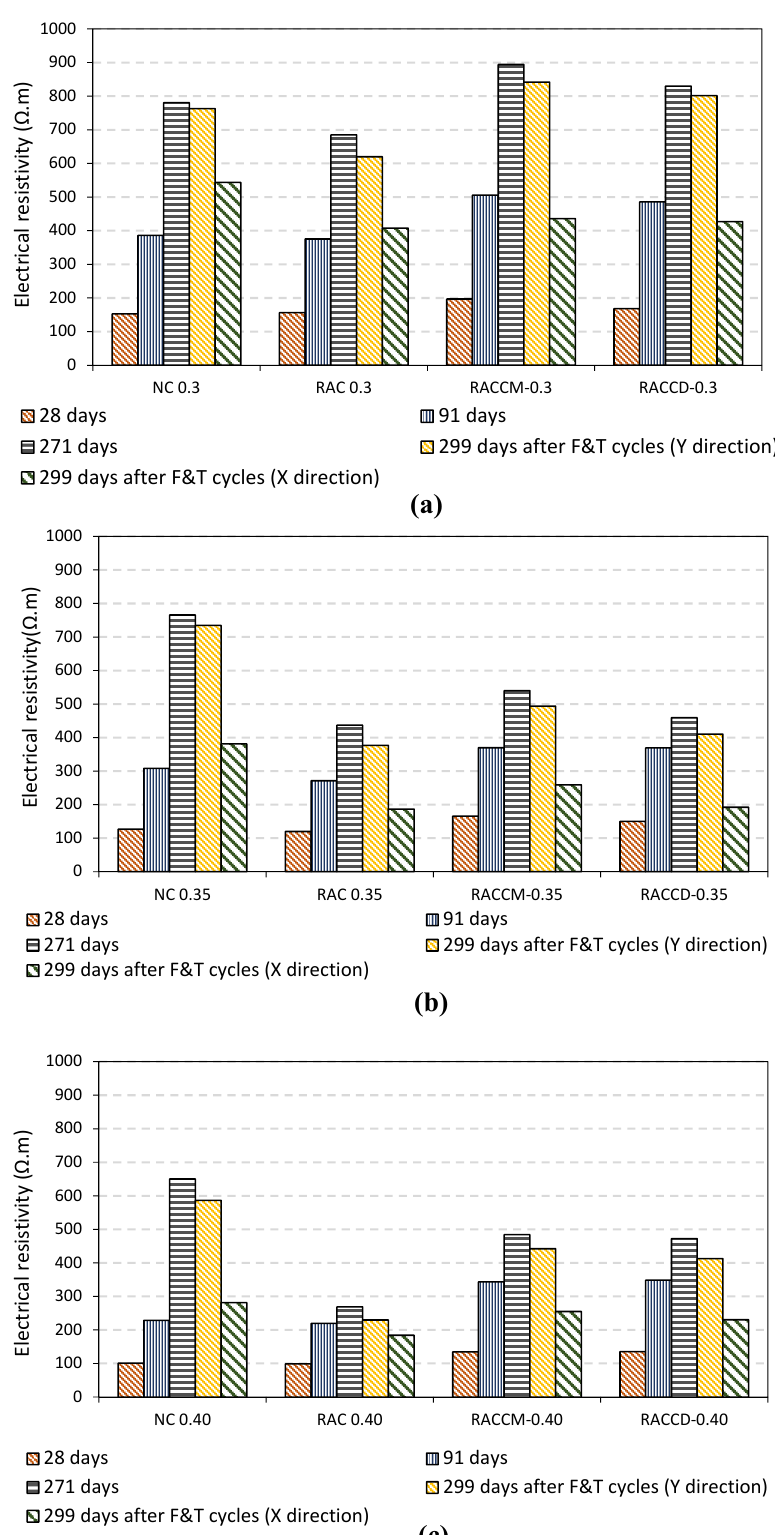
Figure 14. Electrical resistivity of mixes before and after exposure to cycles of freezing and thawing; ( a ) w-c ration 0.30, ( b ) w-c ration 0.35, ( c ) w-c ration 0.40.